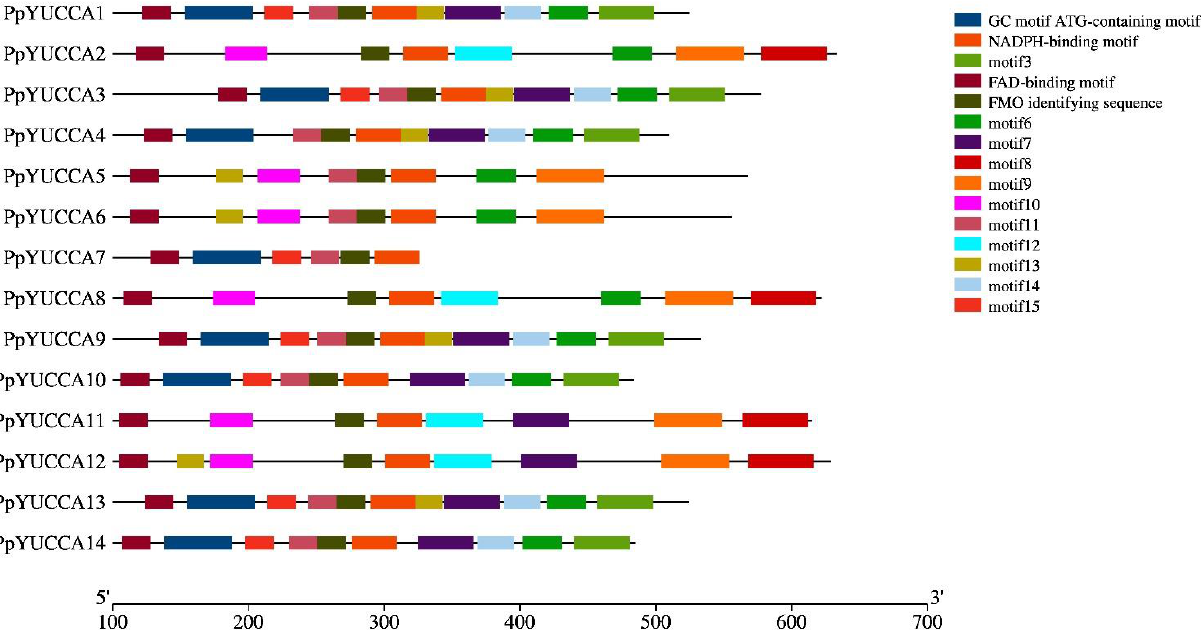
Figure 2. Structure of Prunus persica var. pendula YUCCA genes. Introns, exons, and untranslated regions (UTRs) are represented by black lines, deep orange boxes, and blue boxes, respectively.